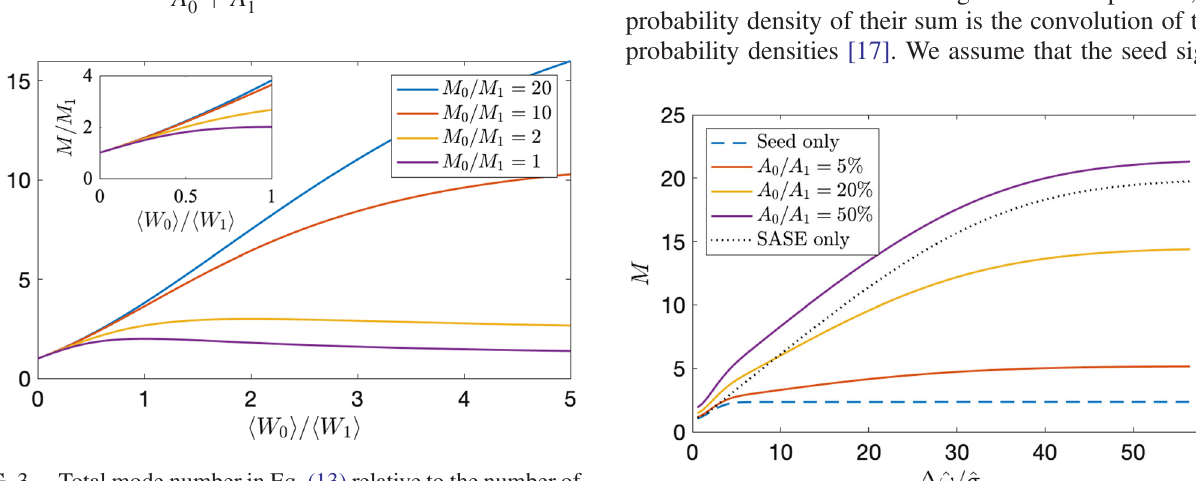
ffiffiffi p ffiffiffi p π π and ˆ σ A ¼ 20